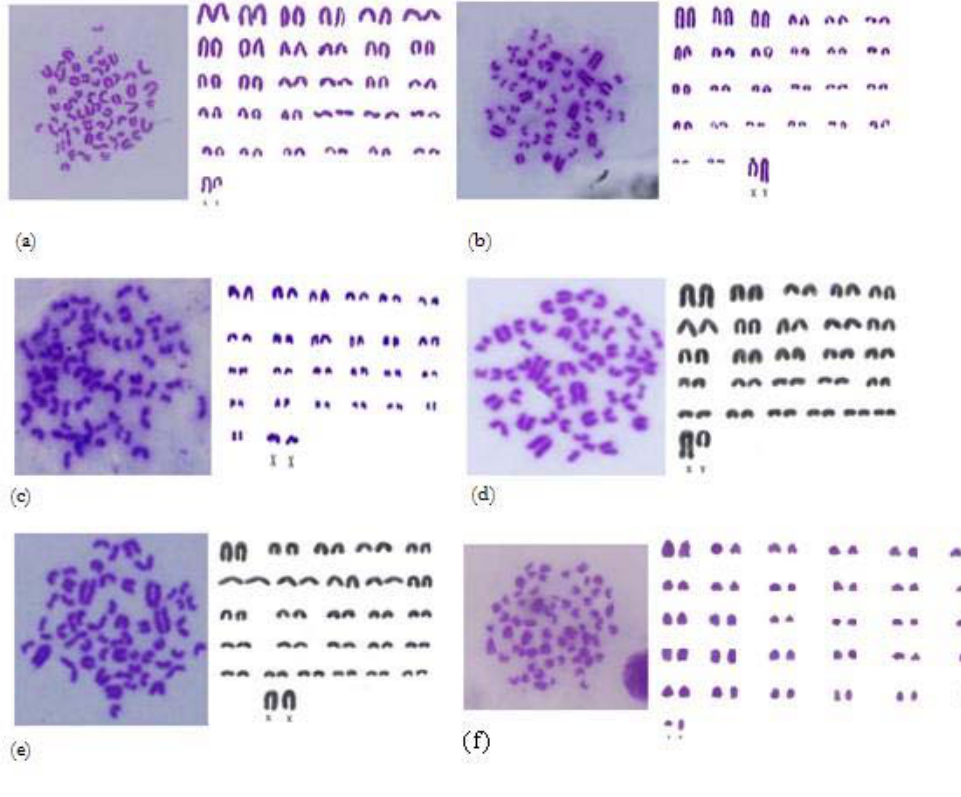
F IGURE 5. Metaphase spreads and idiograms of genus the Microtus . (a) Microtus socialis (b) M. qazvinensis (c) M. transcaspicus (d, e) M. levis (f) M. paradoxus.